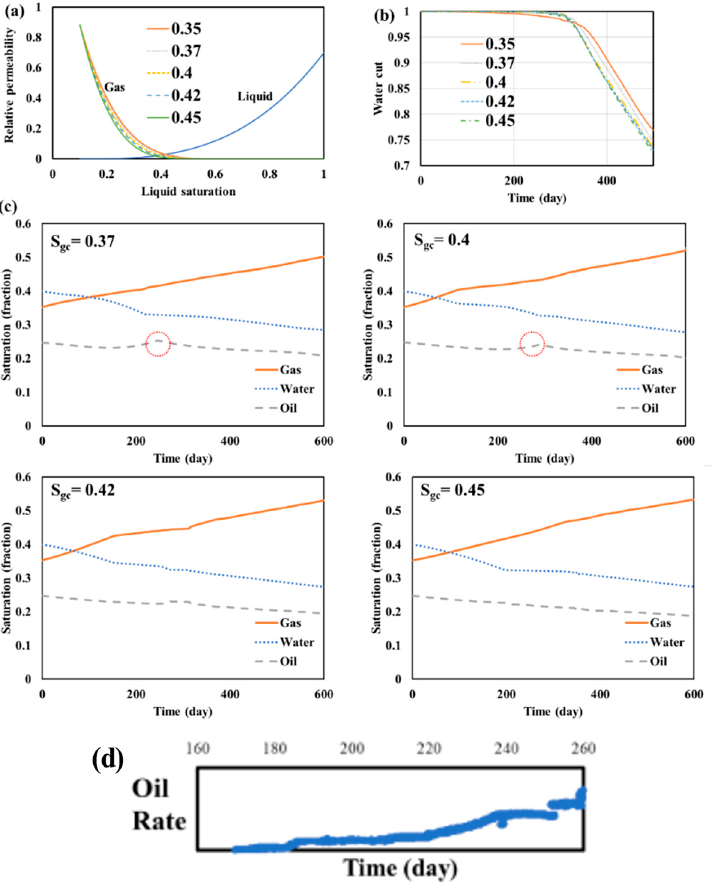
Figure 6. ( a ) Gas–liquid relative permeability curves with different critical gas saturations; ( b ) water-cut behavior with corresponding critical gas saturation; ( c ) gas/water/oil saturation at the grid of the reservoir center with different critical gas saturations; ( d ) oil rate production data from one shale oil in the target formation (actual numerical values blurred processed for confidentiality purpose), oil breakthrough is observed at about 170 days.